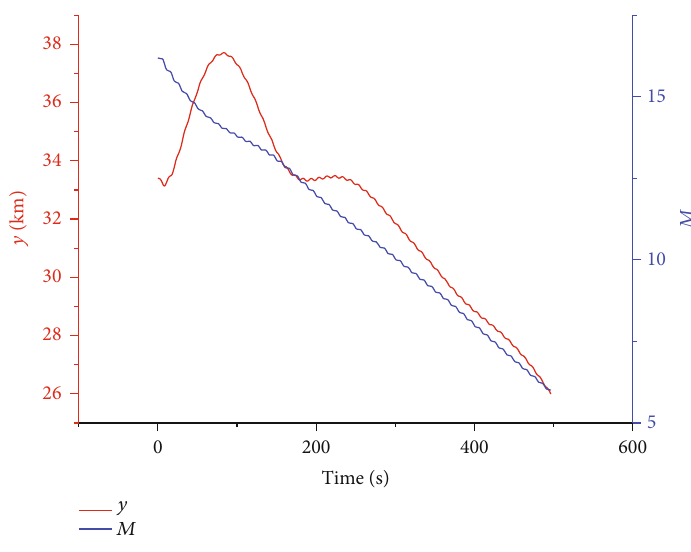
Figure 20: Altitude and Mach number with attitude control.